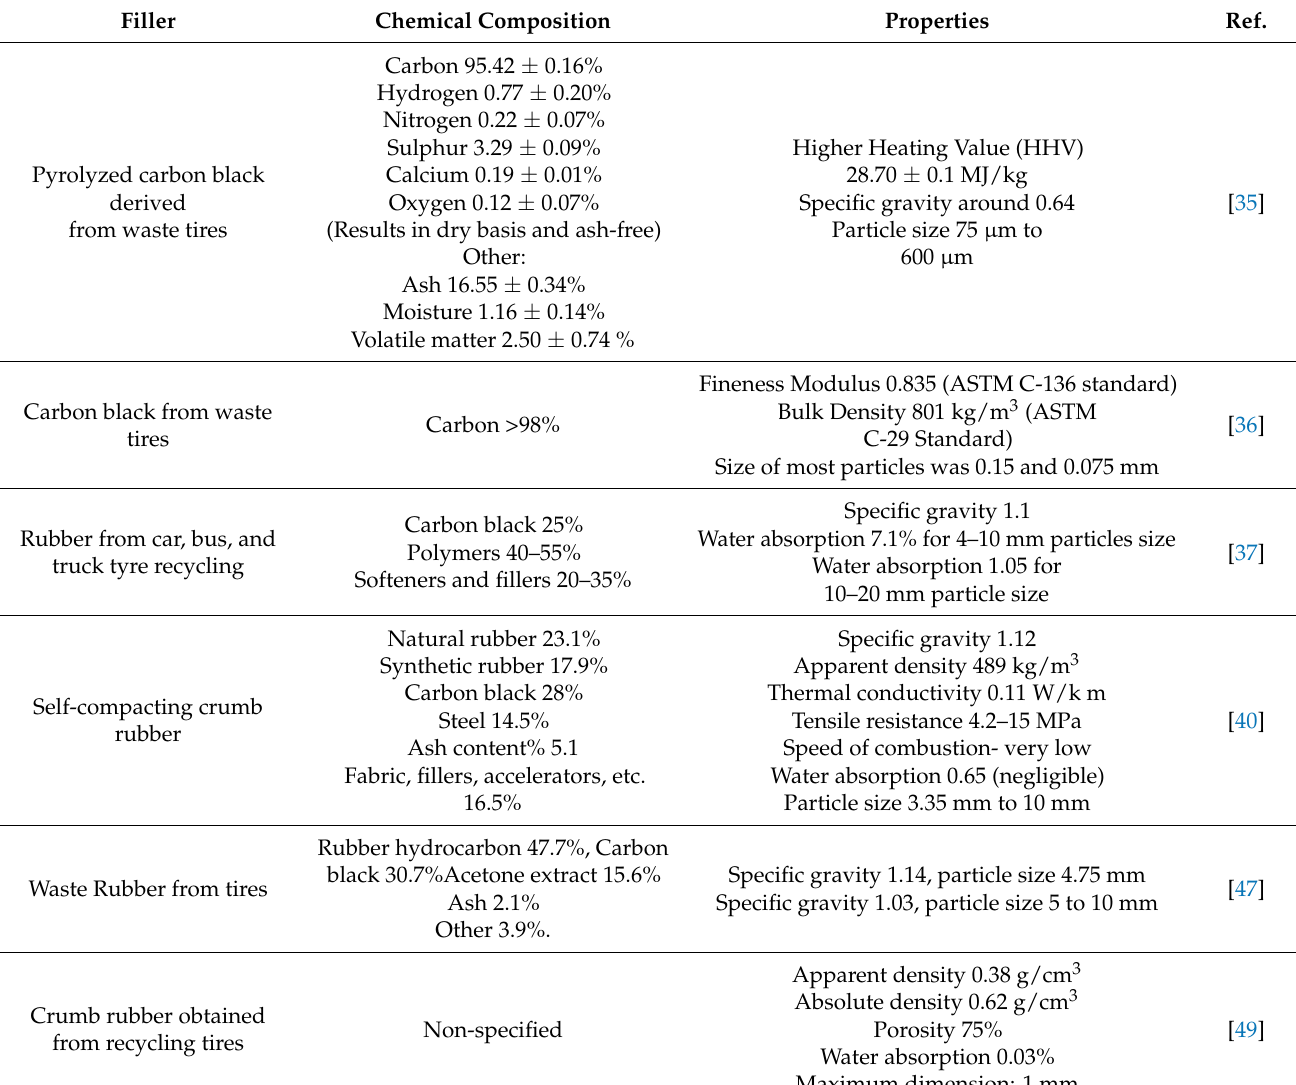
Table 1. The types of rubber-based additives including their filler type, chemical composition, and properties, based on [35–37,40,47,49].